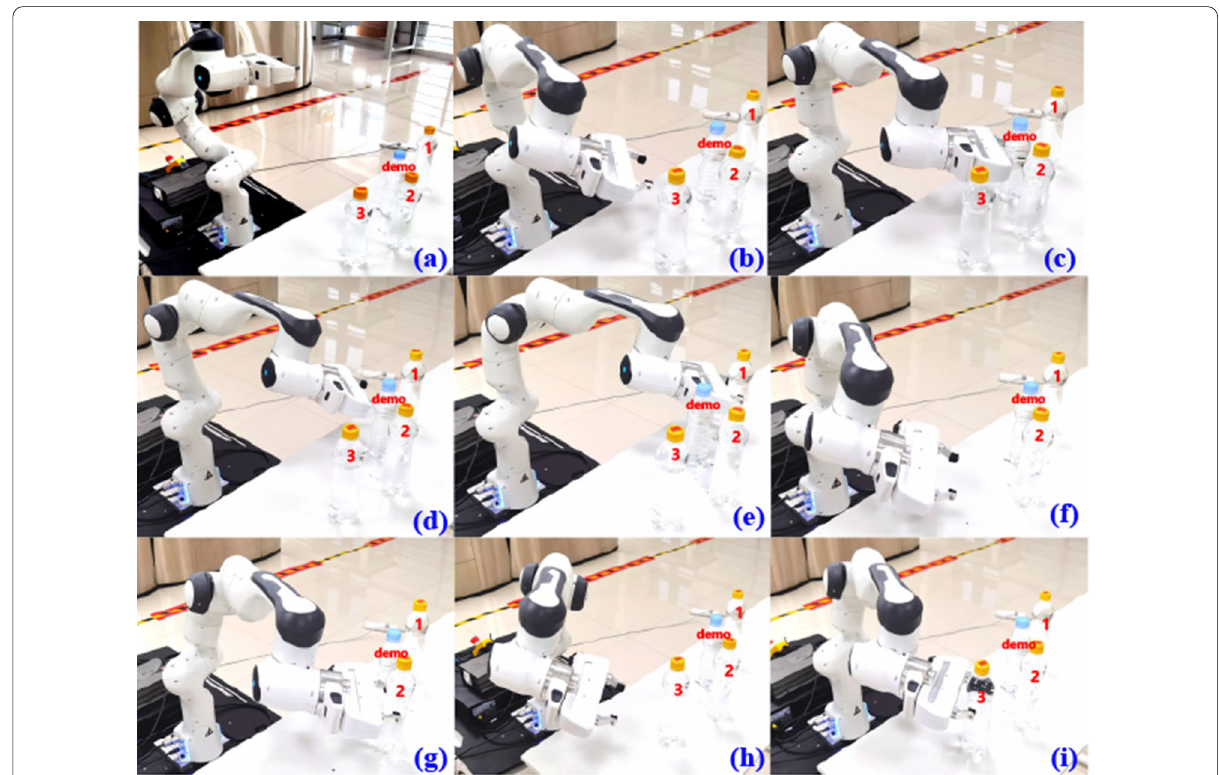
Figure 7 Experimental results of the pick-up task with different